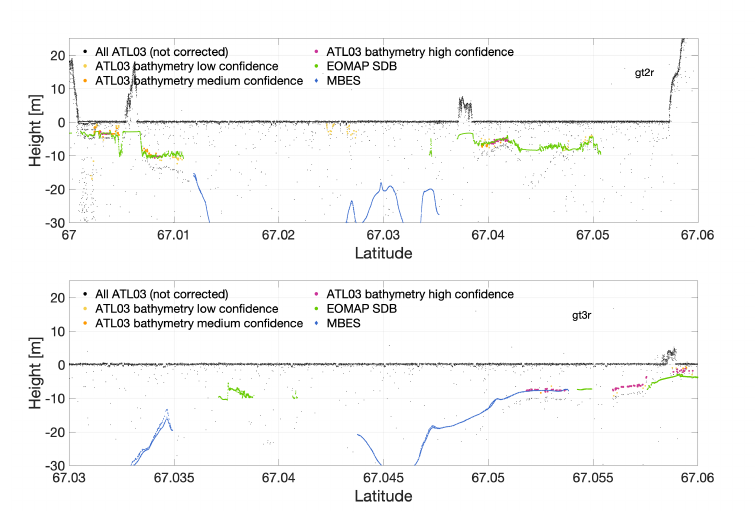
Figure 14. Figure showing the different bathymetry profiles as well as all the ATL03 photon data from ICESat-2 track 529. The ICESat-2 data were acquired on 2 November 2018.